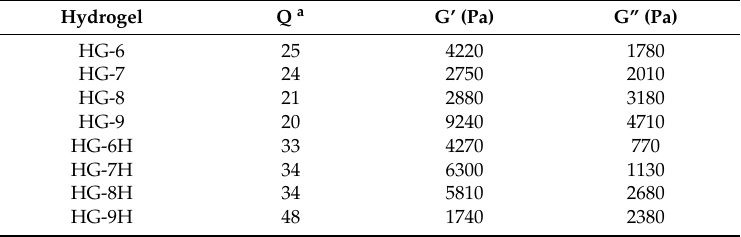
Table 4. Storage (G (cid:48) ) and loss (G”’) moduli (at ω = 10 rad / s) of hydrogel series HG-6 to HG-9 and HG-6H to HG-9H at 22 ◦